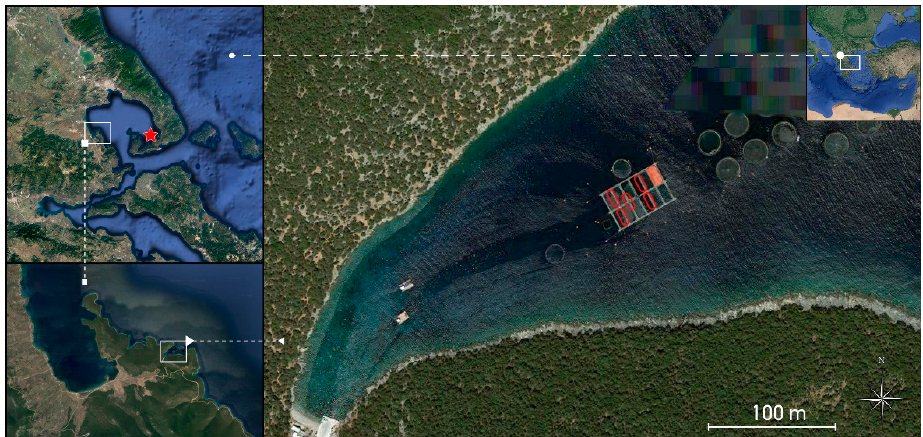
Figure 1. Map of the region and the location of the study area. Red outlines in main map indicate the fish cages where the sampling meshes were deployed. Red star in mini map indicates the location of the other fish farm, which eventually was not included in the study.